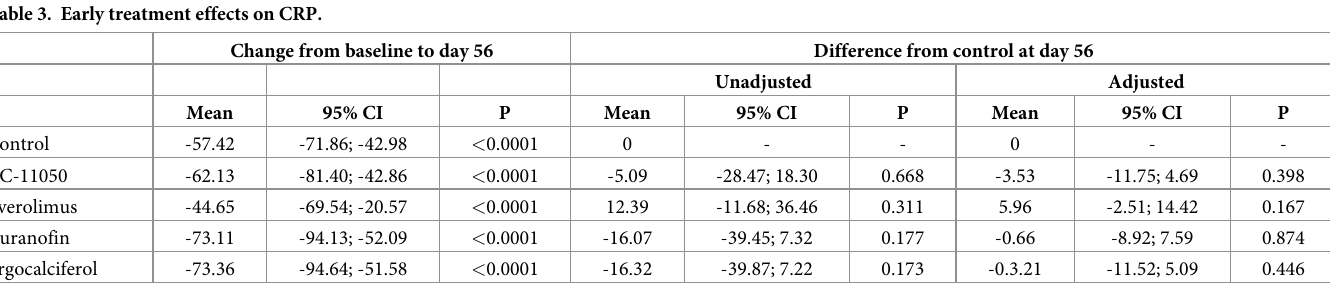
Table 3. Early treatment effects on